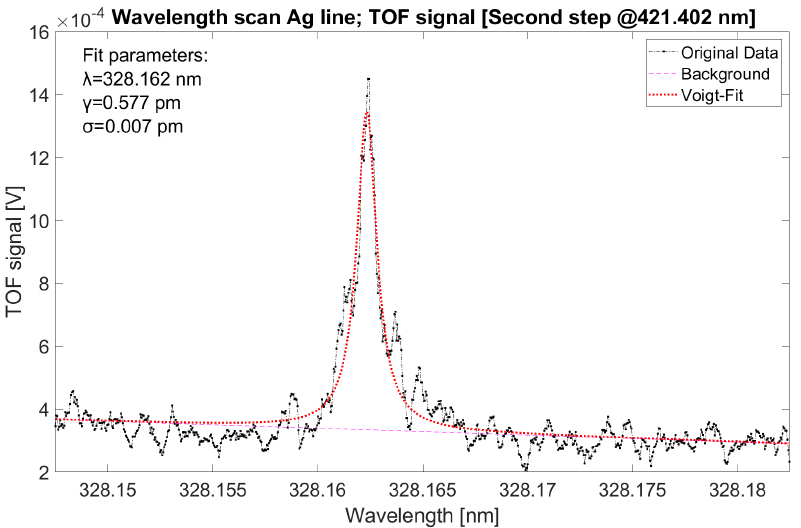
Figure 5. First transition step wavelength scan 4d 10 5s 2 S 1/2 → 4d 10 5p 2 P o (77.9 GHz).